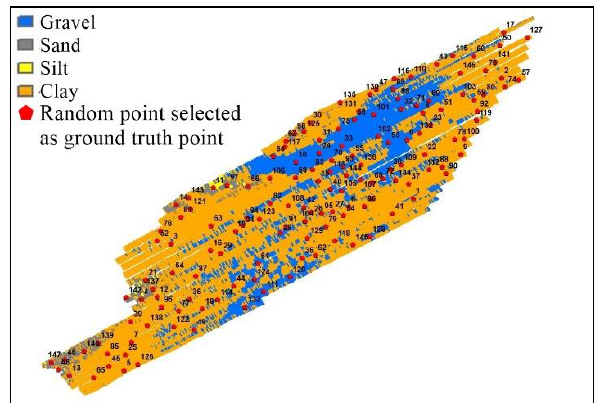
Table 2: Component matrix showing a correlation between rotated PCs and the original variables. Highest factor loads in each PC are highlighted in bold The results from clustering map showed that, for GLCM Correlation and Entropy layers (Figures 4 and 5), the cluster map only showed two dominant classes. For the Contrast layer, the clustering was also showing poor cluster boundary although successfully produced four classes (Figure 5). Only clustering results from GLCM Mean layer showed cluster map with four classes and well delineated class boundary (Figures 6 and 7).